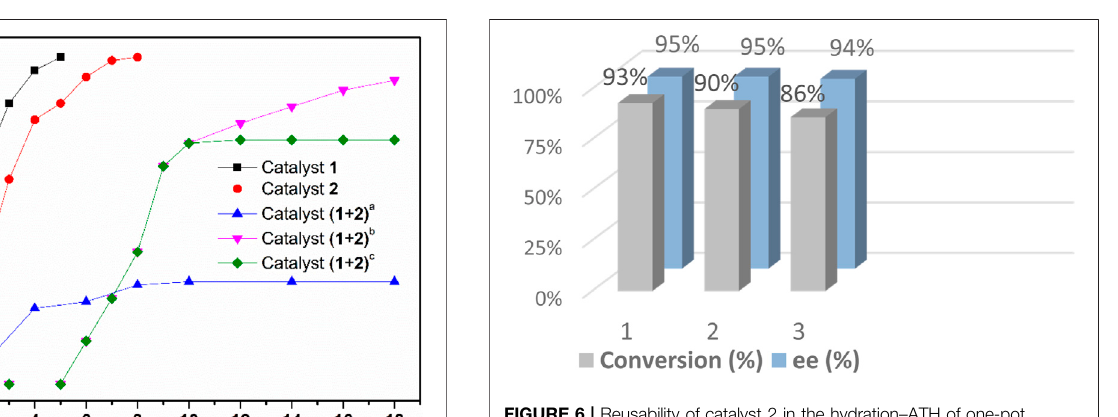
FIGURE 6 | Reusability of catalyst 2 in the hydration – ATH of one-pot tandem reaction of